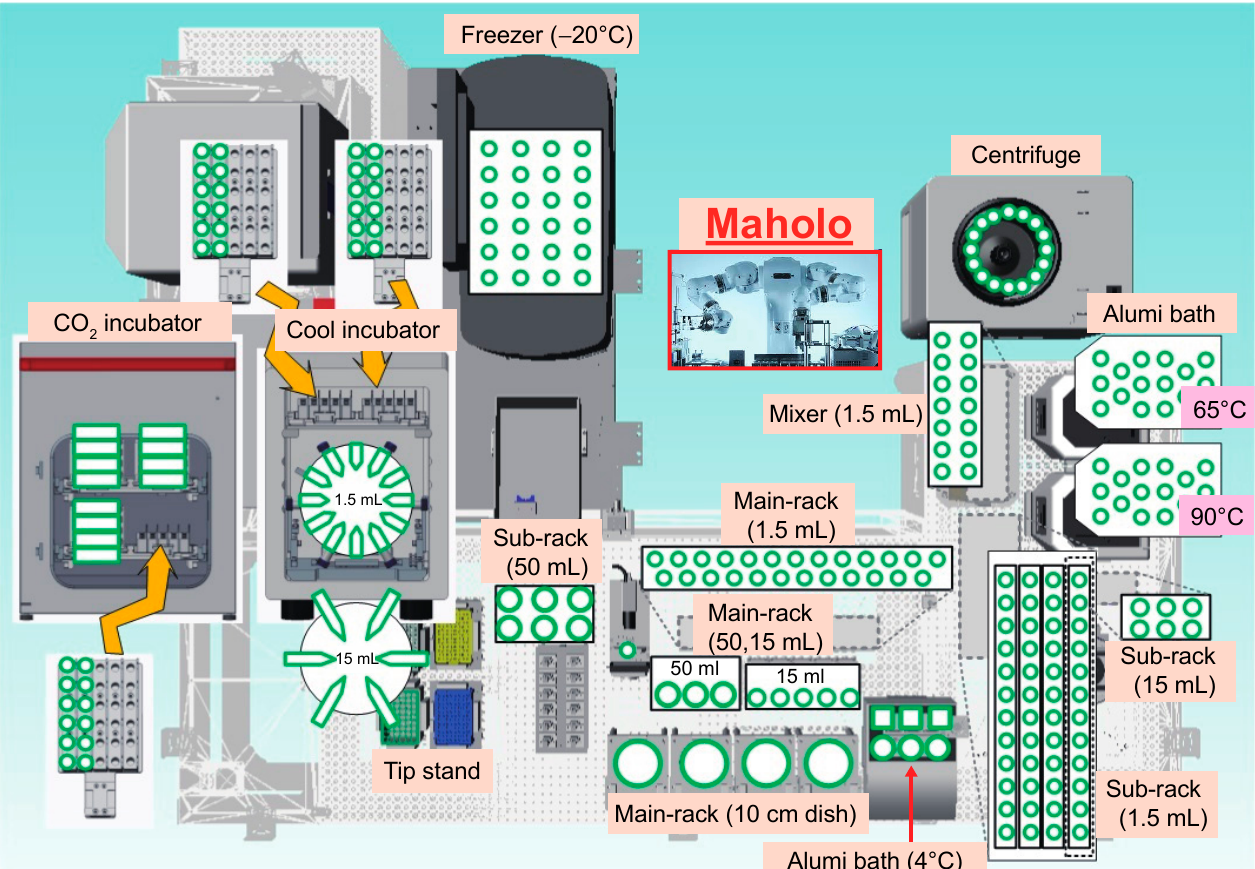
Figure 4. General arrangement drawing for the experimental devices placed around the Maholo. The Maholo is centrally located. Note that the magnetic stand and the refrigerated centrifuge are located in the middle and upper right corner, respectively.